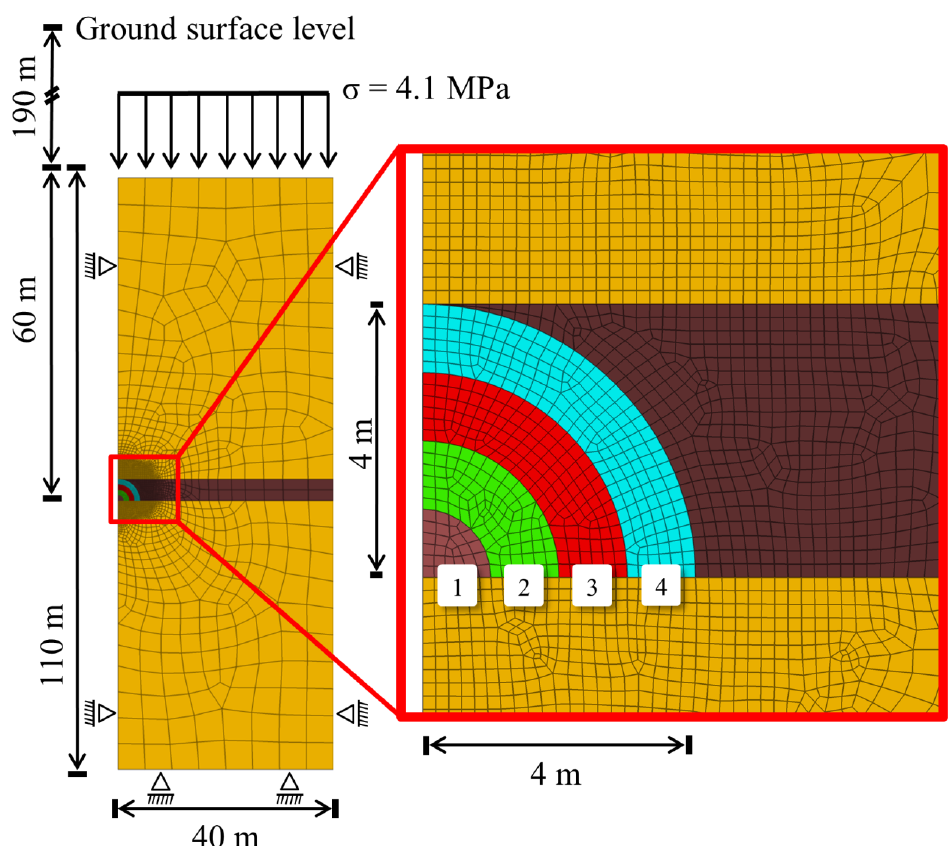
Figure 1. Geometry of the thermo-mechanical coupled 2D UCG model based on simplified geological data of the Hanna UCG trail. The model comprises two sandstone layers (colored in light brown) and one coal seam (colored in dark brown) with four geometric reactor growth steps considered in the simulations (light brown, green, red and